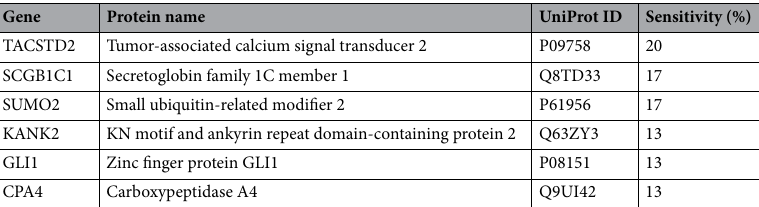
Table 2. Proteins with sensitivity > 10% at a specificity of 90%.